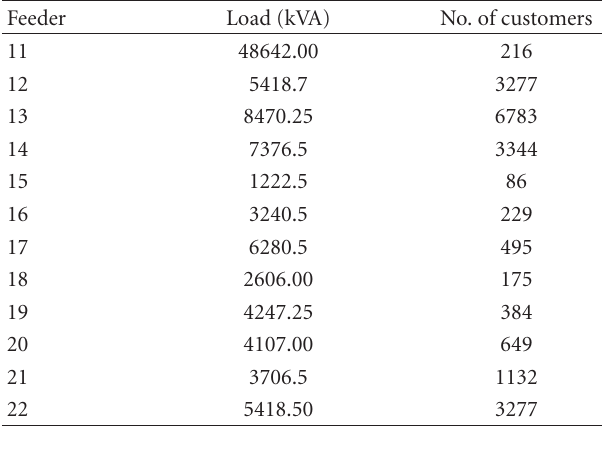
Table 1: Load and customer data for each Feeder.